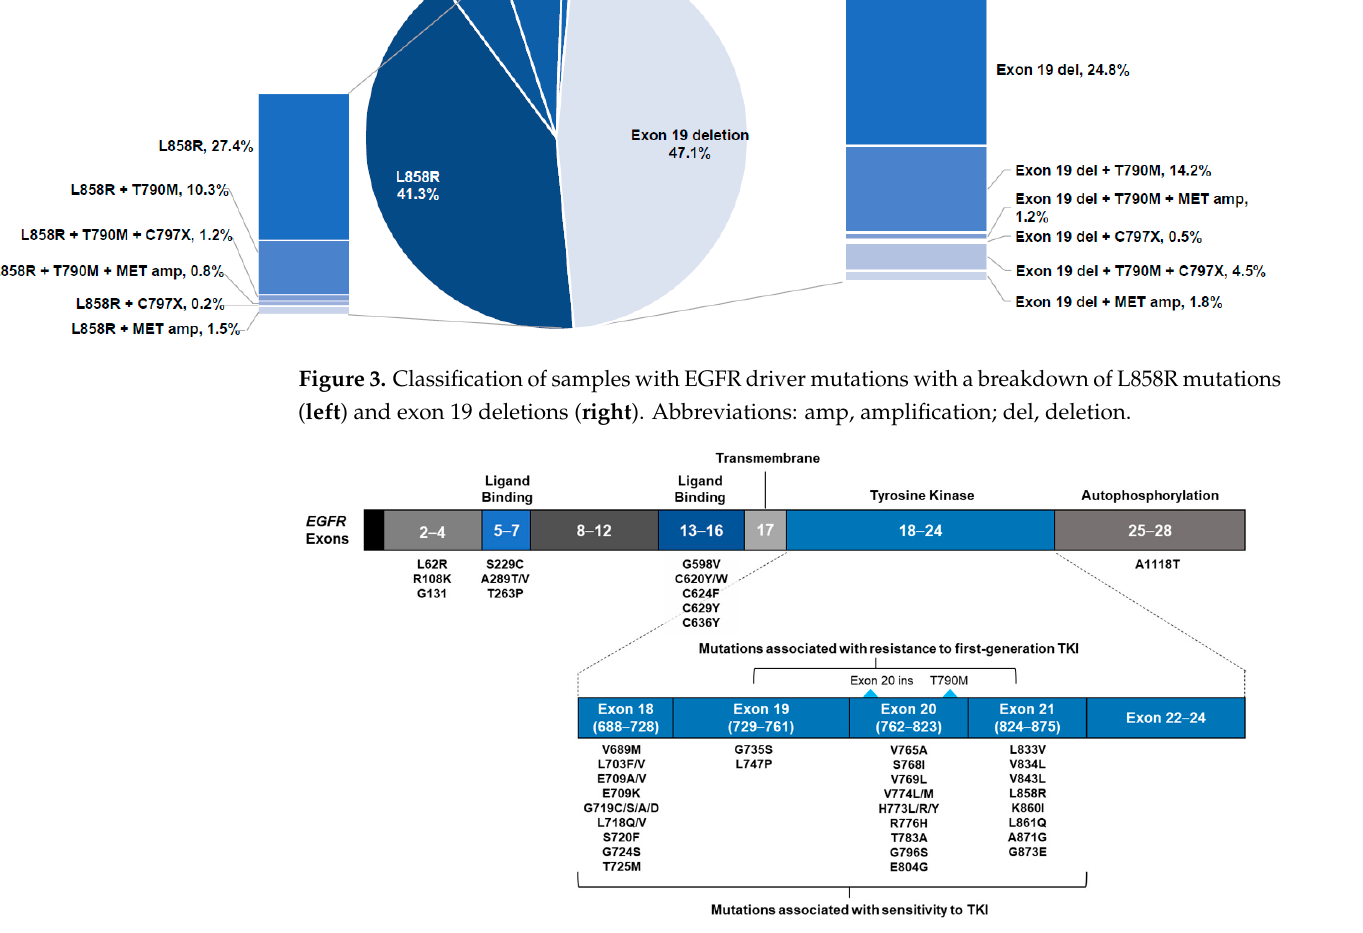
Figure 4. Potentially actionable alterations of the EGFR gene detected in ctDNA in this study. Abbreviations: ctDNA, circulating tumor DNA; EGFR, epidermal growth factor receptor; del, deletion; ins, insertion; SNV, single-nucleotide variant; TKI, tyrosine kinase inhibitor.